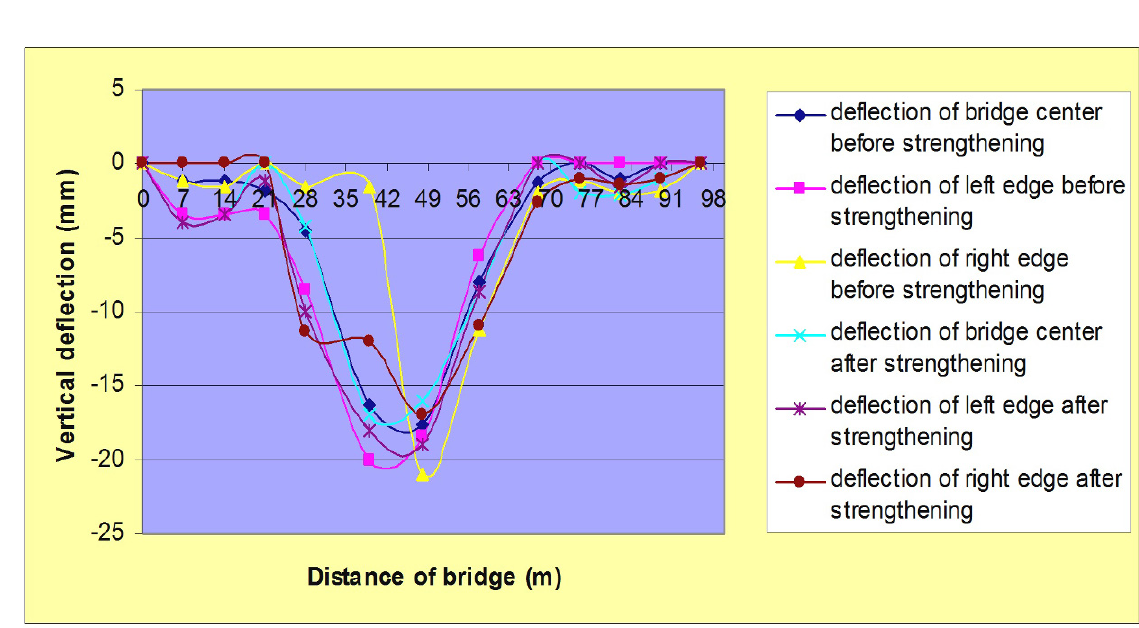
Figure 15. The values of vertical deflection due to load combination II before and after strengthening